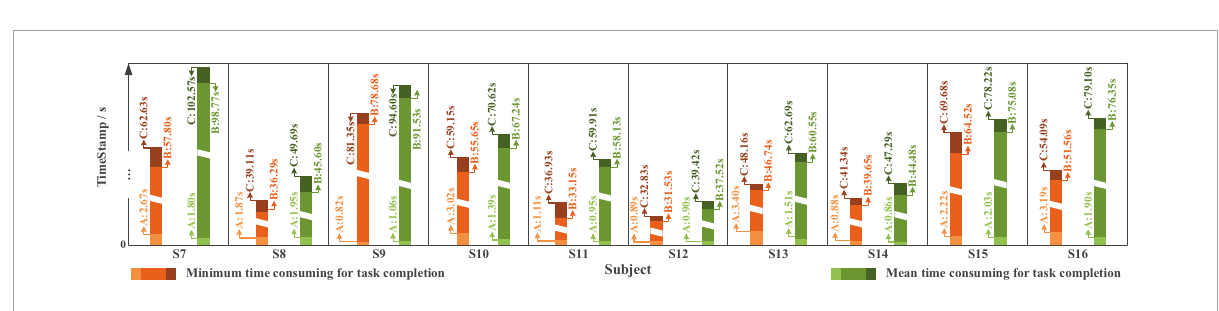
FIGURE24 The time spent in the online experiment for Task two with the slight-facial expression (sFE)-paradigm, where the timestamp A corresponds to ‘System Turn ON’, the timestamp B corresponds to ‘Palm Open,’ and the timestamp C corresponds to ‘System Turn OFF’ (as demonstrated in Figure 22